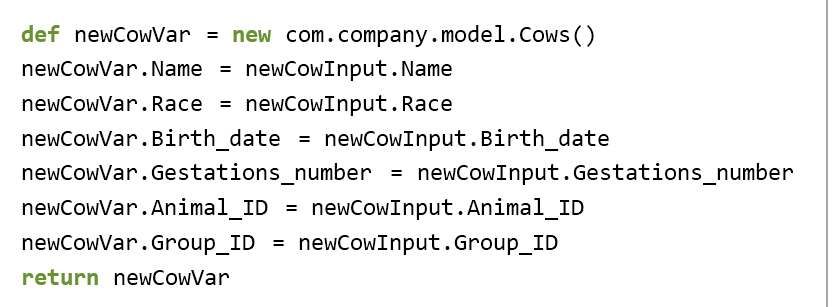
Figure 12. Example of a Groovy script (“initNewCow”) used to create and initialize a new business variable during the execution of the business process “Add new cow”. This business variable is an instance of a business object (Cows) included in the business model of the software application.